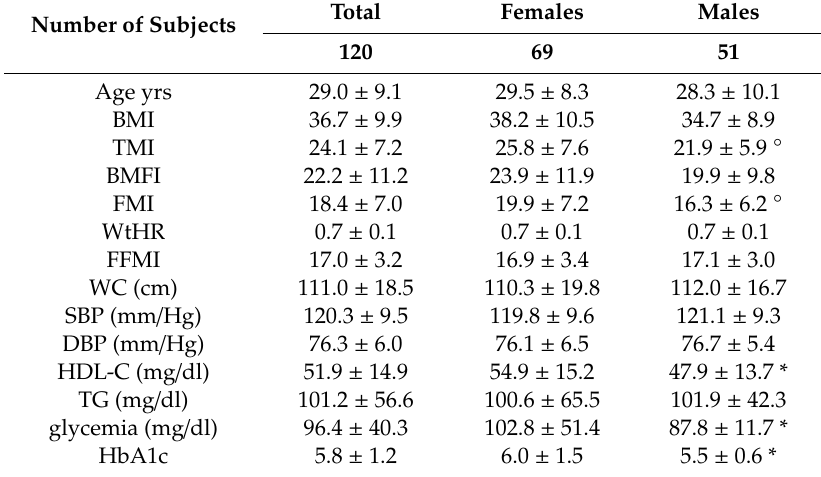
Table 2. Comparison between females and males with and without metabolic syndrome (MetS). For significance: & p < 0.05 for the di ff erence vs. females; * p < 0.005 for the di ff erence vs. females.